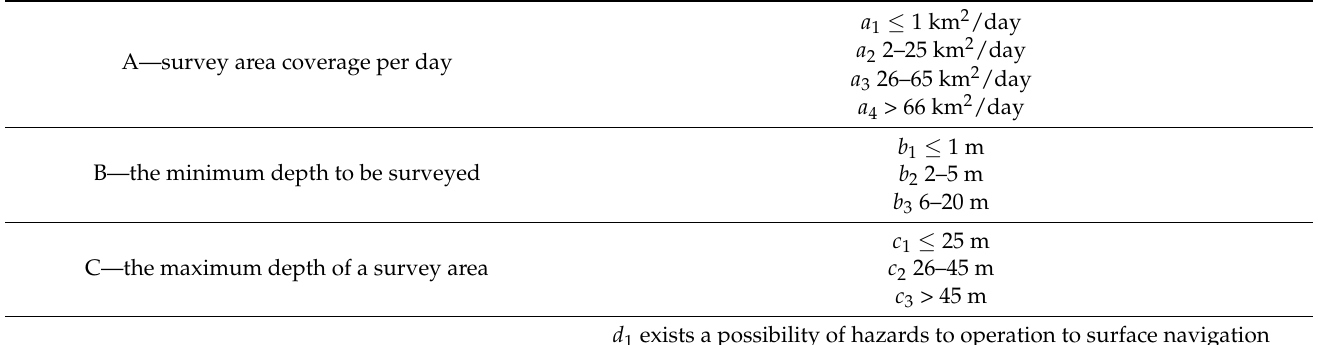
Table 1. Proposed distribution of characteristics and sub characteristics of the survey